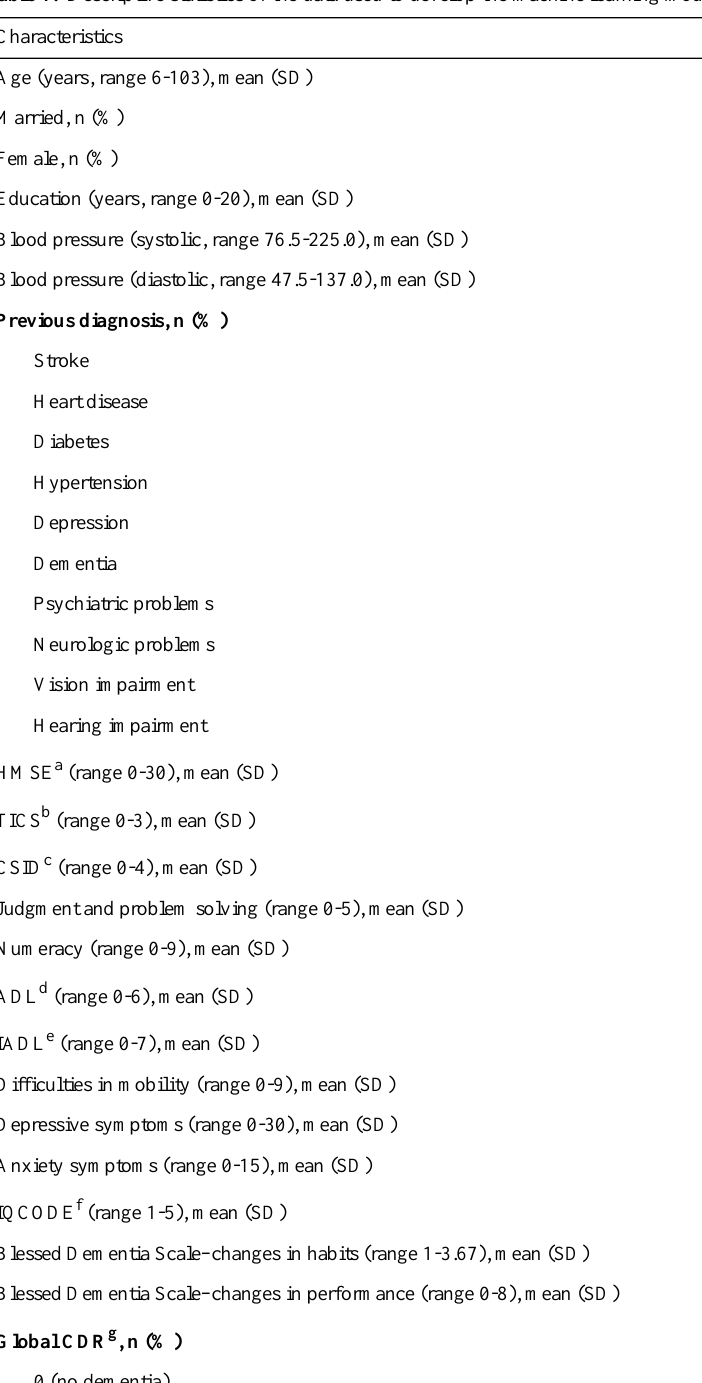
Table 1. Descriptive statistics of the data used to develop the machine learning model (n=2528).